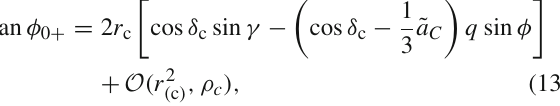
the B + → π + K 0 amplitude and neglecting the colour- suppressed EW penguin contributions (see Sect. 3.3.2),